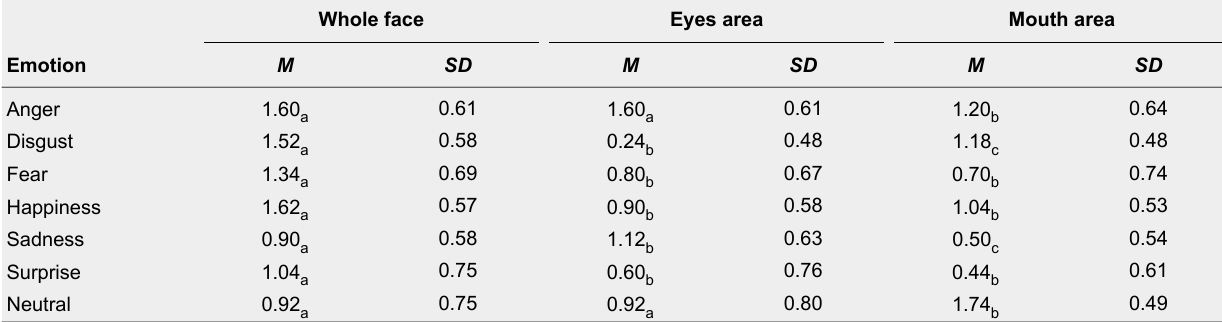
Children’s Performances in Detecting Emotions From a Specific Face